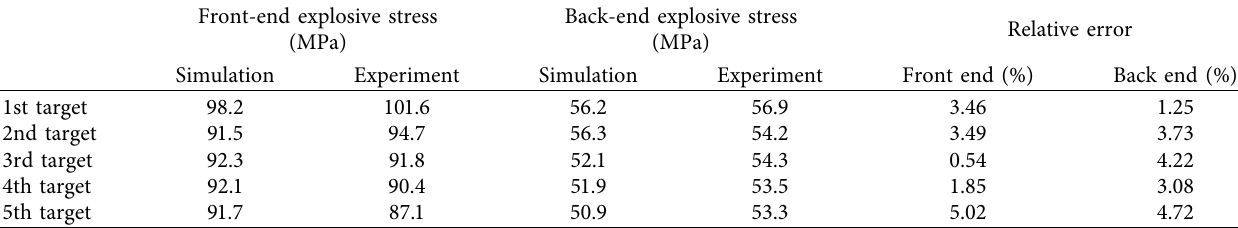
Table 4: Simulation results, experiment results, and relative